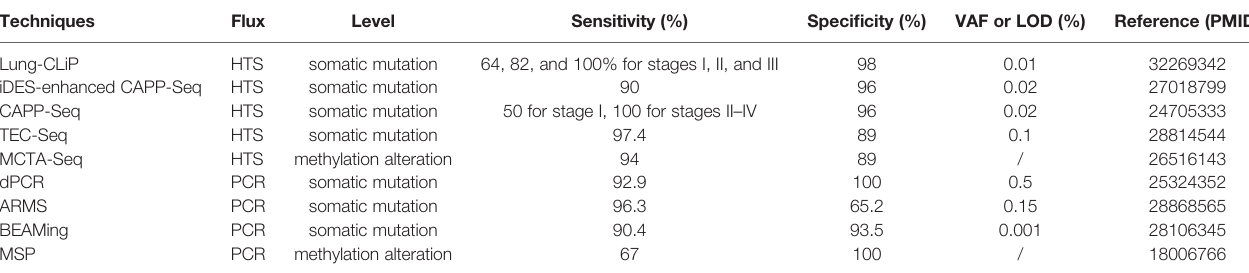
TABLE 1 | Comparison of techniques in ctDNA detection.